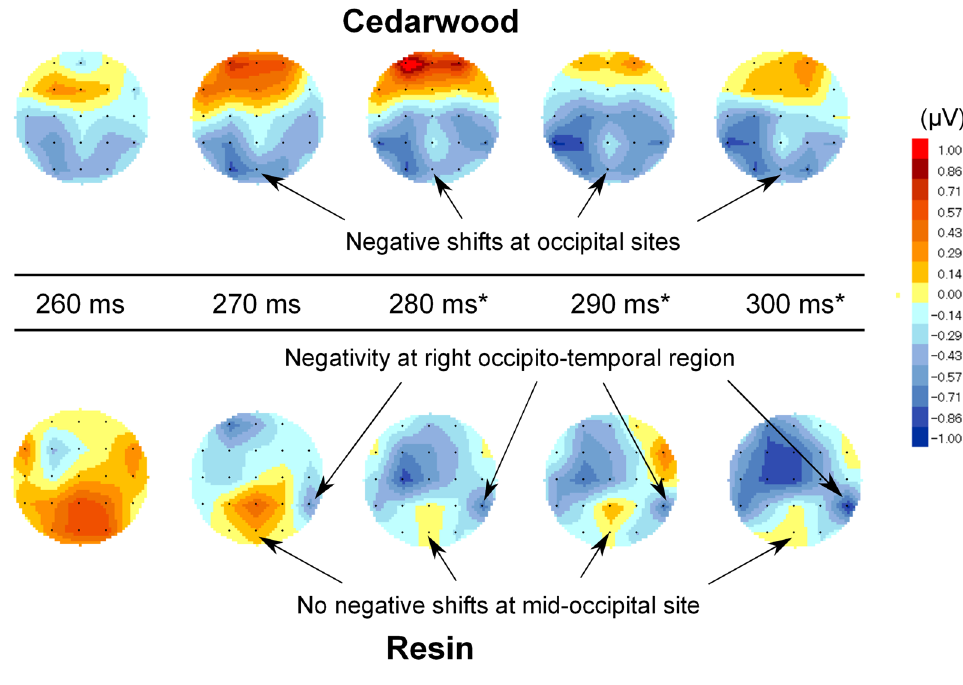
Fig. 6 Topographical maps of the grand-averaged occipital negativity in the middle latencies (260–300 ms) in response to the infrequent stimuli in the cedarwood and resin huts. ERPs to frequent stimuli were subtracted from the ERPs to infrequent stimuli for the topographic mapping. In the topography, blue indicates negativities. Note that the negative component was observed at the occipital region under the cedarwood condition, whereas in the resin condition, the negativity was not obvious at the mid-occipital electrode but was observed at the right occipitotemporal